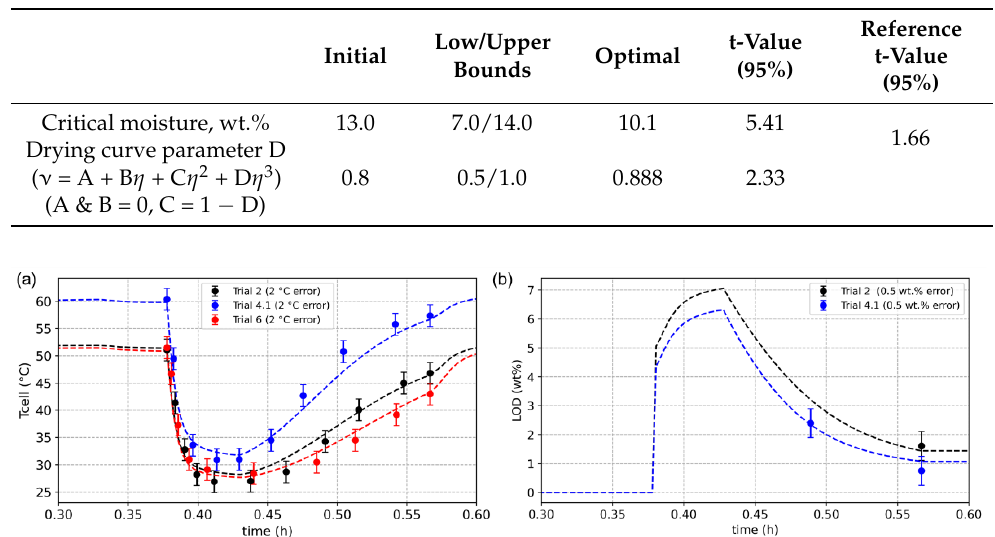
Table 4. Initial guesses, lower and upper bounds, optimal value of each parameter in seg-FBD drying model, t-value (95%), and reference t-value (95%).